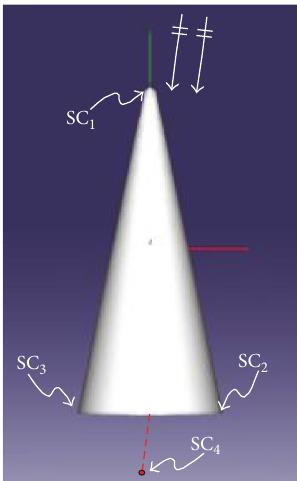
Figure 11: Positions of four dominated scattering centers on the target.